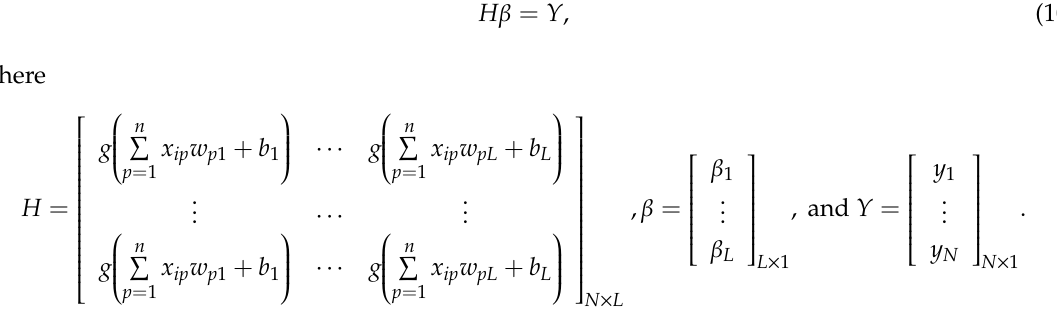
weight between the p th input layer neurons and the j th hidden layer neurons and b j denotes j th bias of hidden layer neurons. β j denotes j th weight between hidden layer neurons and output layer